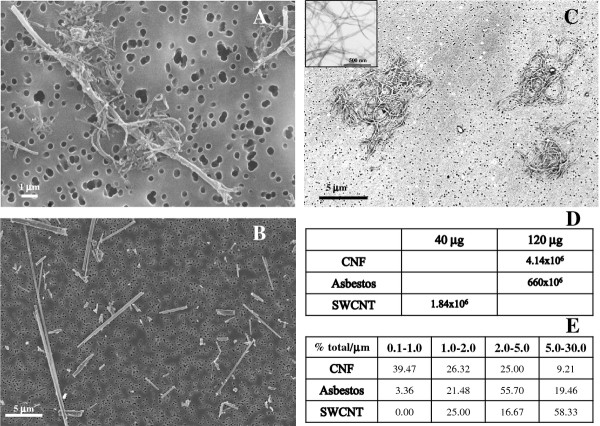
Scanning Electron Microscopy images of CNF (A), asbestos (B), SWCNT (C, Inset: TEM showing individual roped SWCNT), structure numbers per dose (D) and particles size (length) distribution (E) presented as % of total particles.